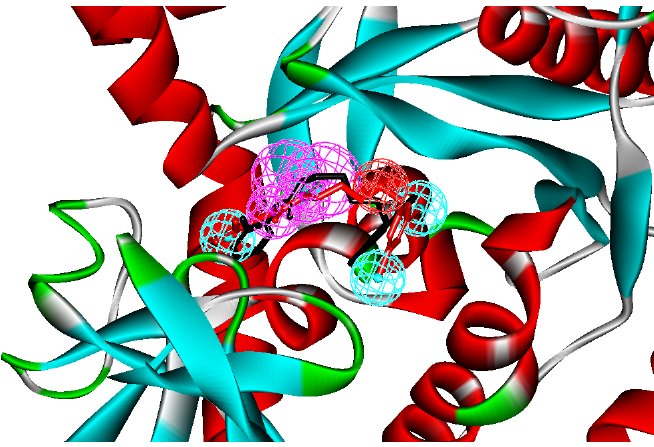
Figure 2. The mapping of the structure-based pharmacophore and the best mapping conformation (red bars) and the bound conformation (black bars) for the ligand to methione tRNA synthetase (MetRS) are superimposed on the pharmacophore model. Screenshots were taken from Discovery Studio. Features of the pharmacophore models are color-coded as follows: Hydrogen bond acceptor (HBA), green; hydrogen bond donor (HBD), violet; hydrophobic (H), light blue; positive ionizable (pos),